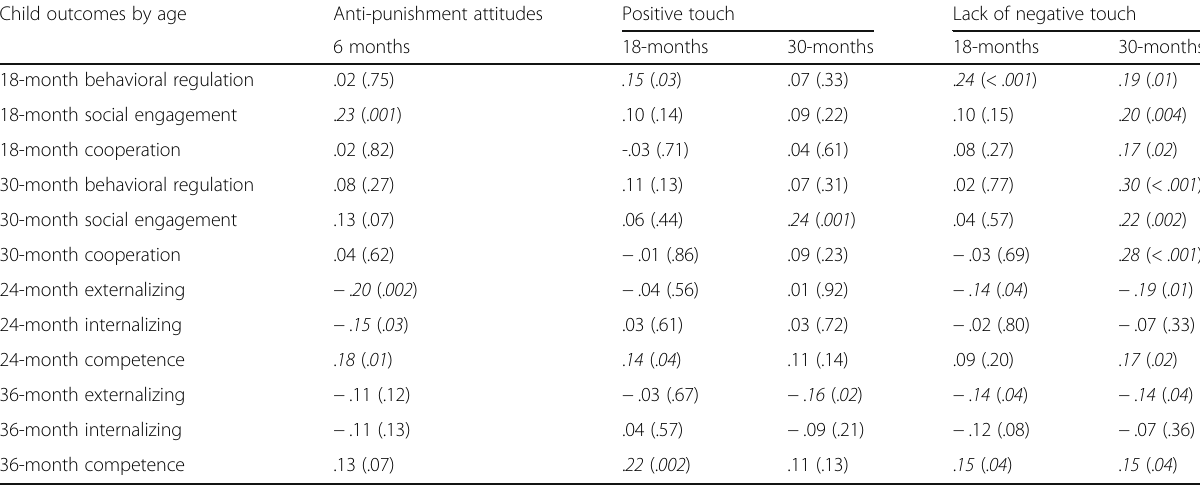
Table 3 Study 2 partial correlations among maternal anti-punishment attitudes, touch behavior, and child sociomoral outcomes Child outcomes by